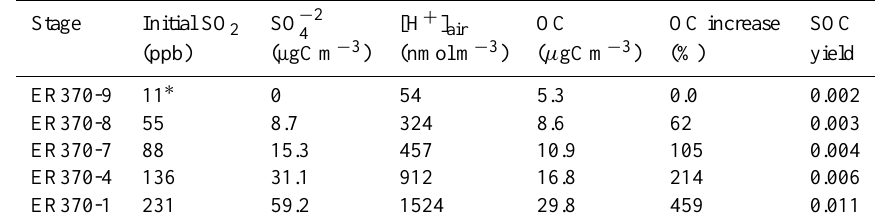
Table 1. Isoprene SOA as a function of sulfate acidity from the photooxidation of SO 2 . Stage